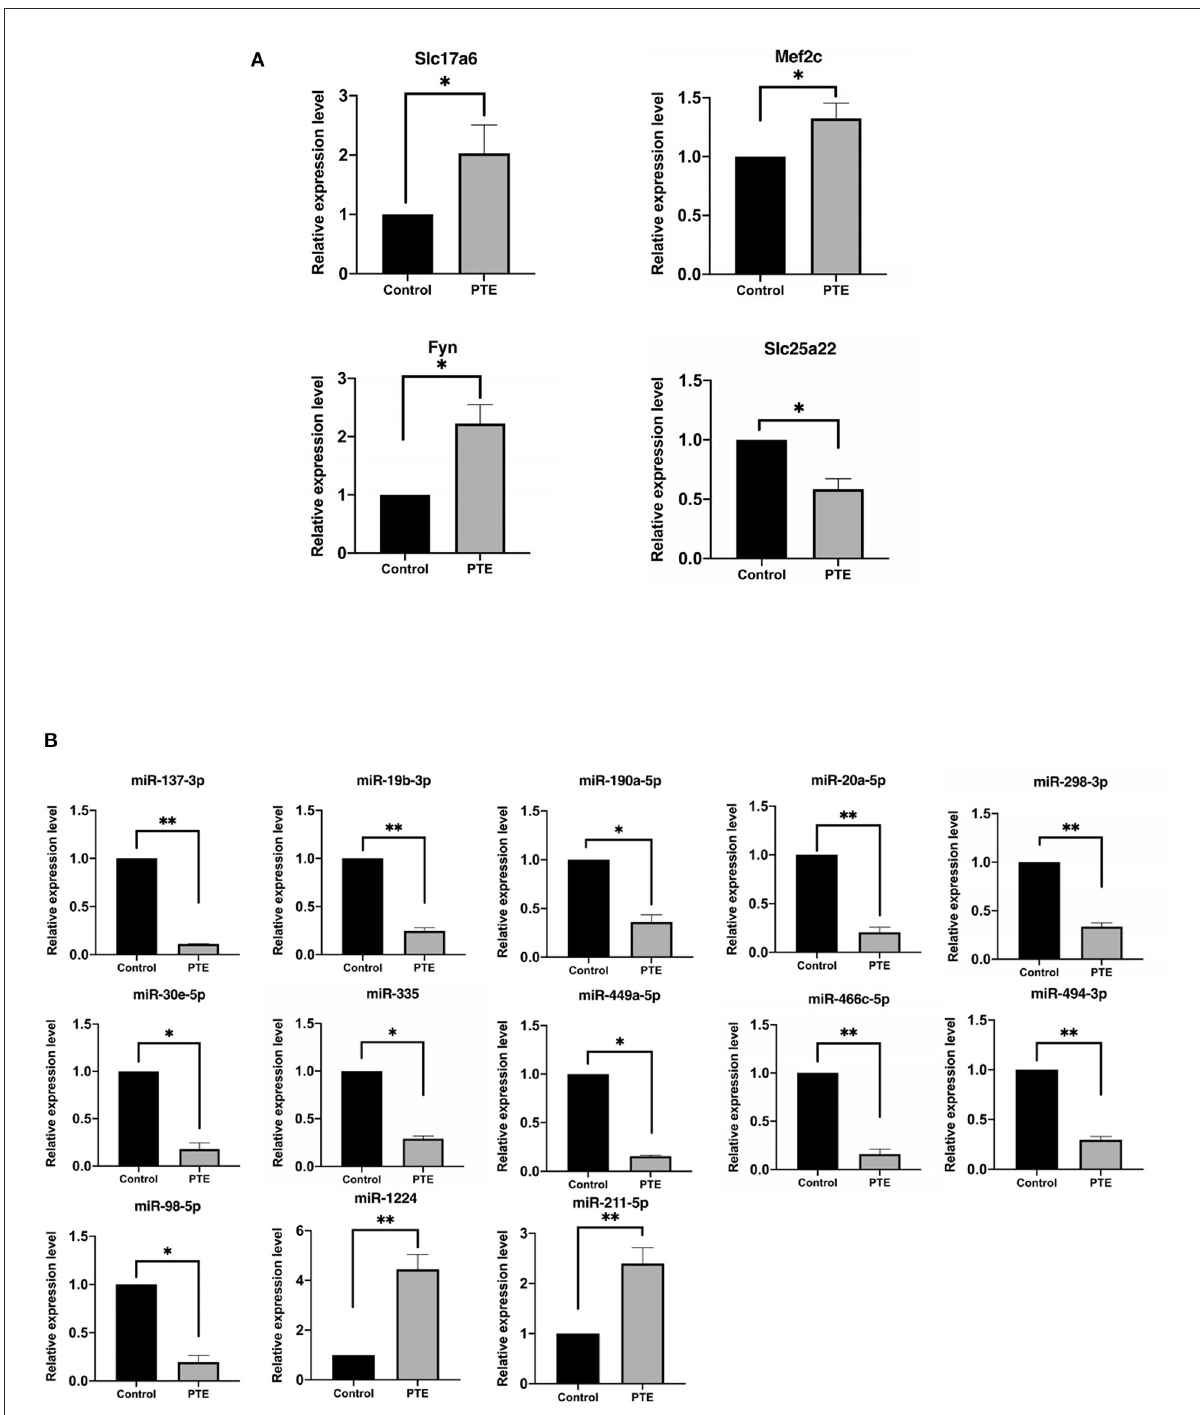
FIGURE5 Quantitative real-time PCR verification of differentially expressed glutamatergic-related mRNAs and microRNAs. * P < 0.05, ** P < 0.01 vs. sham group. (A) The expression of verified mRNAs (Slc17a6, Mef2c, and Fyn) in PTE group was significantly increased compared with the control group, and the expression of verified mRNAs (Slc25a22) in PTE group was significantly decreased compared with the control group. (B) The expression of verified microRNAs (miR-137-3p, miR-19b-3p, miR-190a-5p, miR-20a-5p, miR-298-3p, miR-30e-5p, miR-335,